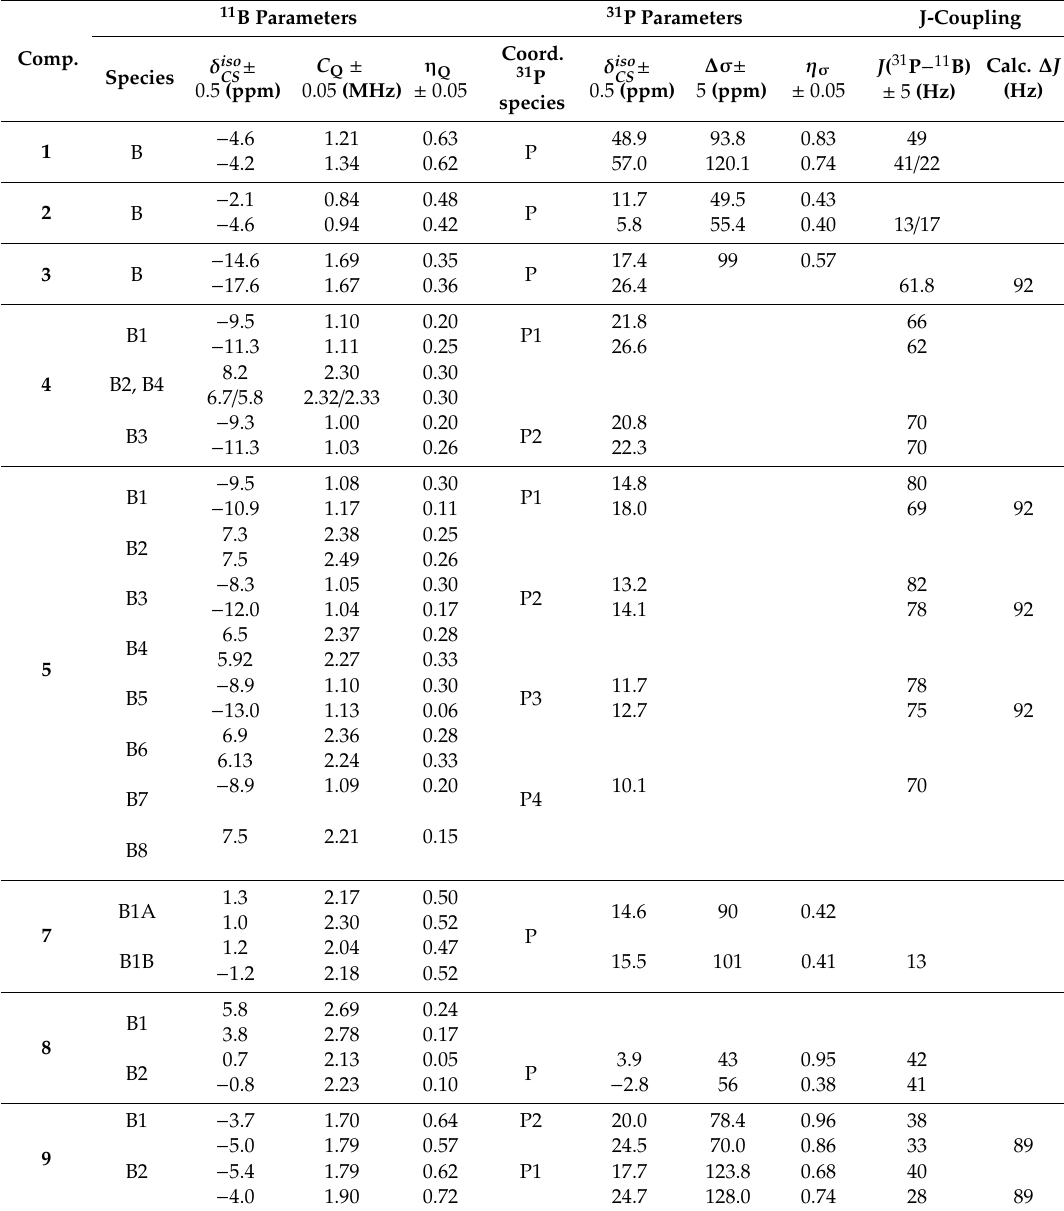
Table 1. Solid-state NMR parameters of FLP Aggregates 1 – 9 a .